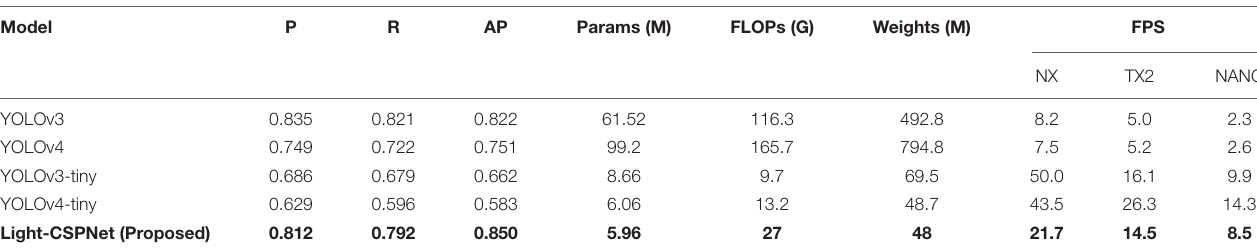
TABLE 4 | Test results for the apple